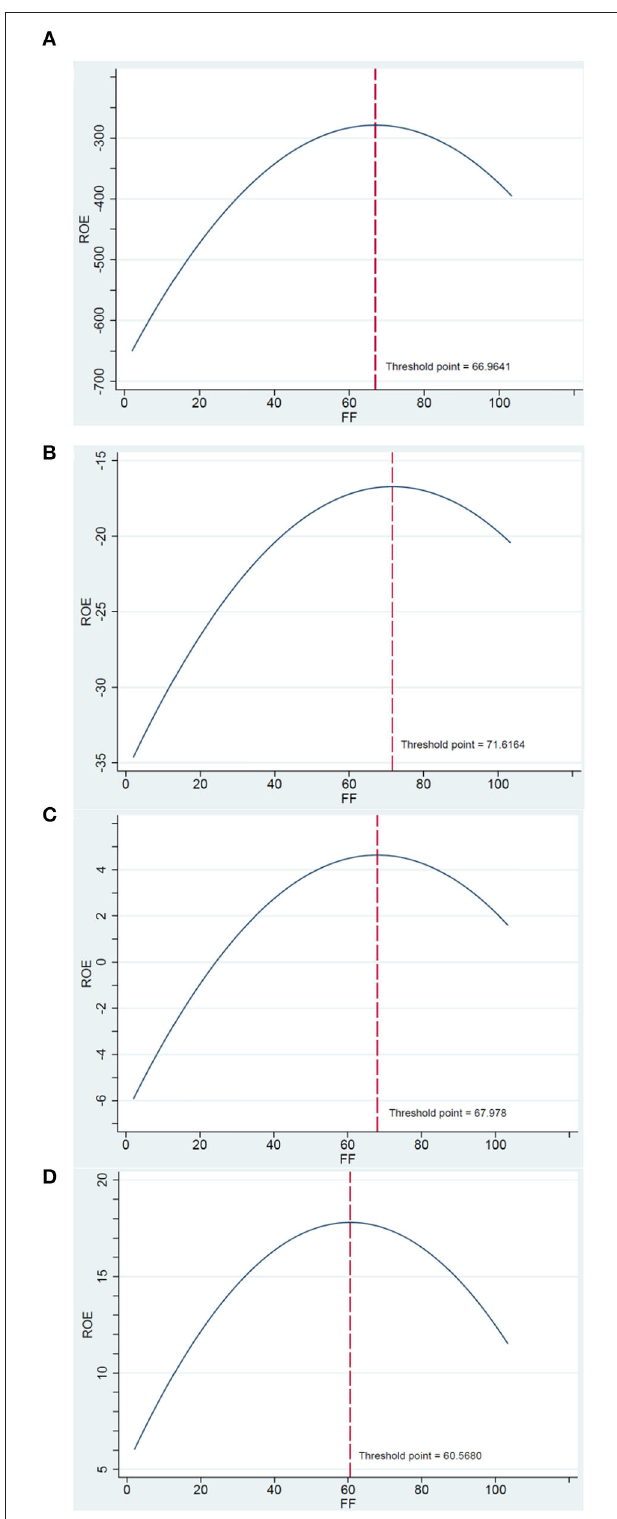
FIGURE 1 | The inverted U–shaped financial flexibility (FF)-firm performance (FP) nexus for hotel companies in (A) 10th, (B) 50th, (C) 75th, and (D) 90th